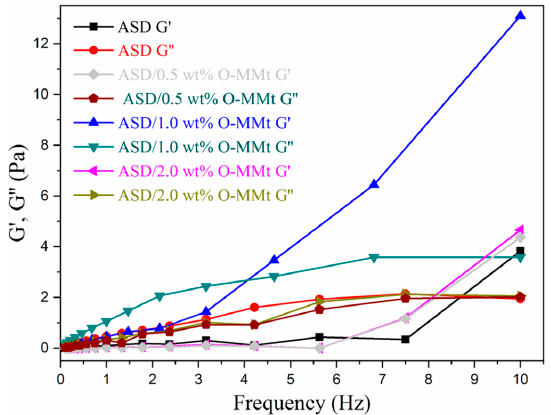
Figure 15. Elastic (G ′ ) and viscous (G ″ ) moduli as a function of frequency for ASD, ASD/0.5 wt% O-MMt, ASD/1.0 wt% O-MMt, and ASD/2.0 wt% O-MMt.